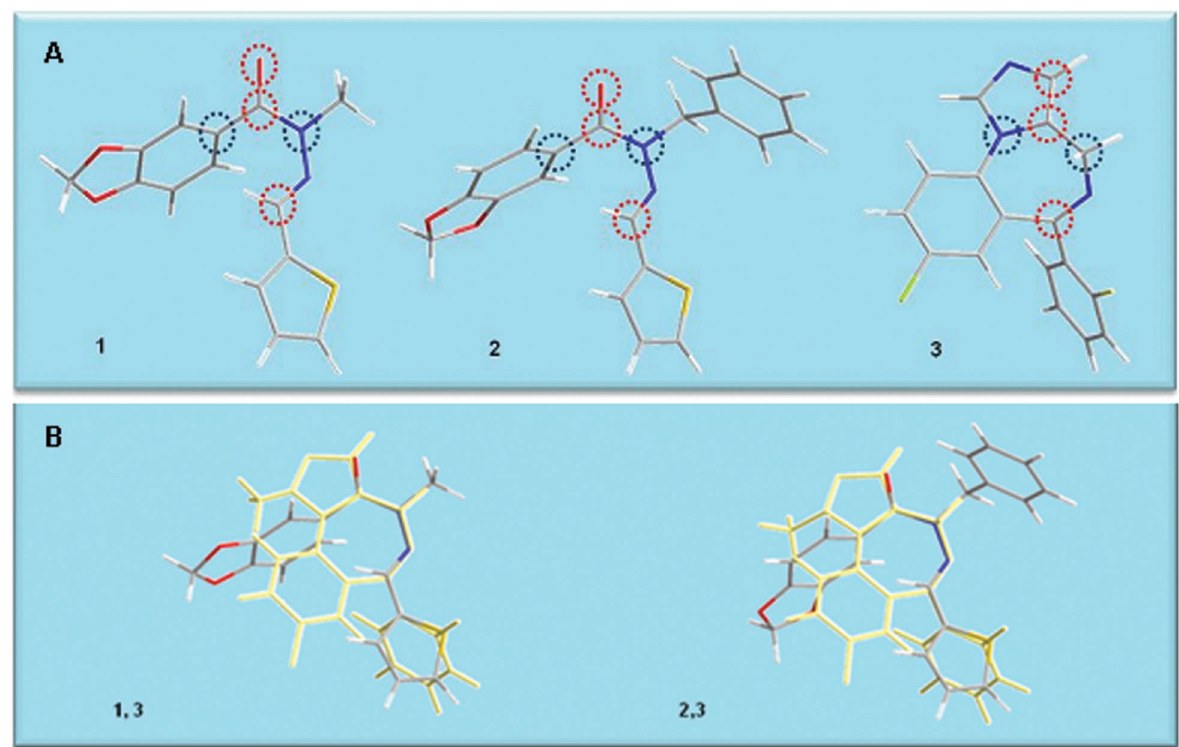
Figure 4. Structural correlation between the N -acylhydrazone (NAH) derivatives LASSBio-785 and LASSBio-786 and the benzodiazepine compound midazolam. The atoms were colored as follows: carbon (gray), hydrogen (white), oxygen (red), and nitrogen (blue). The circles indicate the atoms used for the alignment of the structures. A , Chemical structures of LASSBio-785 (1), LASSBio-786 (2), and midazolam (3). B , Superimposition of compounds 1 vs 3 (yellow structure) and 2 vs 3 (yellow structure), aligned by the central NAH